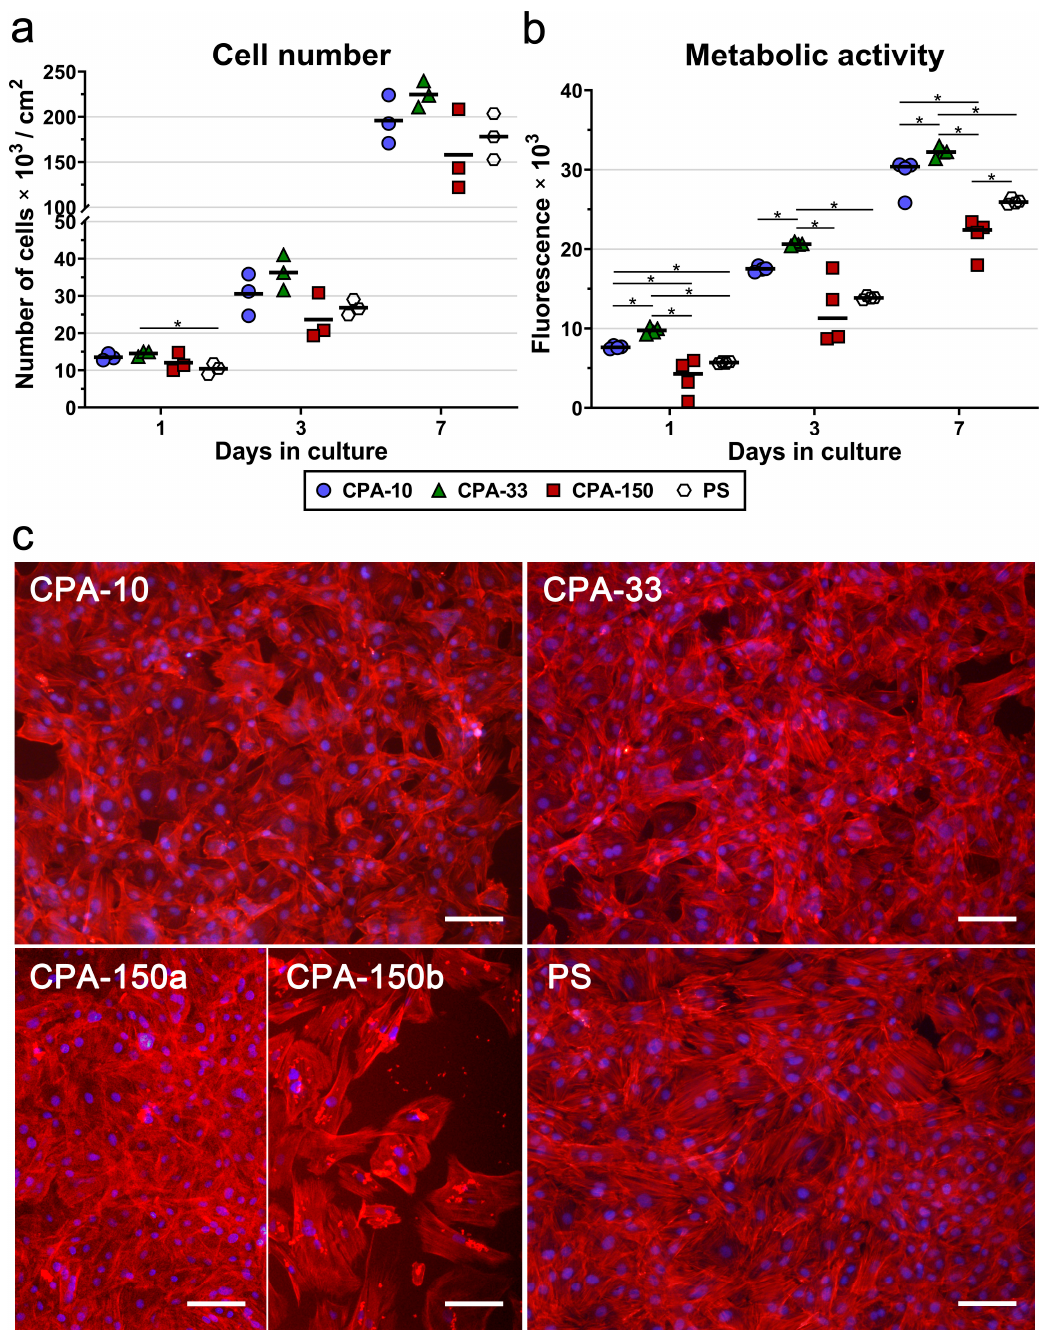
Figure 5. ( a ) Proliferation, ( b ) metabolic activity, and ( c ) morphology of VSMCs cultured on PS culture dishes coated with PP films, deposited at the average RF power ( P av ) of 10, 33, and 150 W (labelled as CPA-10, CPA-33, and CPA-150, respectively), evaluated within 7 days of cultivation. ( a , b ) The dots represent individual biological samples. Each dot depicts the arithmetic mean calculated ( a ) from cell numbers obtained from a minimum of 15 pictures per biological sample or ( b ) from three pipetting replicates per biological sample. The bold central lines show ( a ) the arithmetic mean and ( b ) the median of biological samples. Statistically significant differences ( p ≤ 0.05) are marked by horizontal lines with asterisks connecting the differing samples. ( c ) Images of the cells were captured 7 days after seeding by an epifluorescence Olympus IX-71 microscope. Cell nuclei are visualized by Hoechst #33258 (blue), while the cell membrane and the actin cytoskeleton are visualized by Phalloidin-TRITC (red). The scale bar depicts 100 μ m.